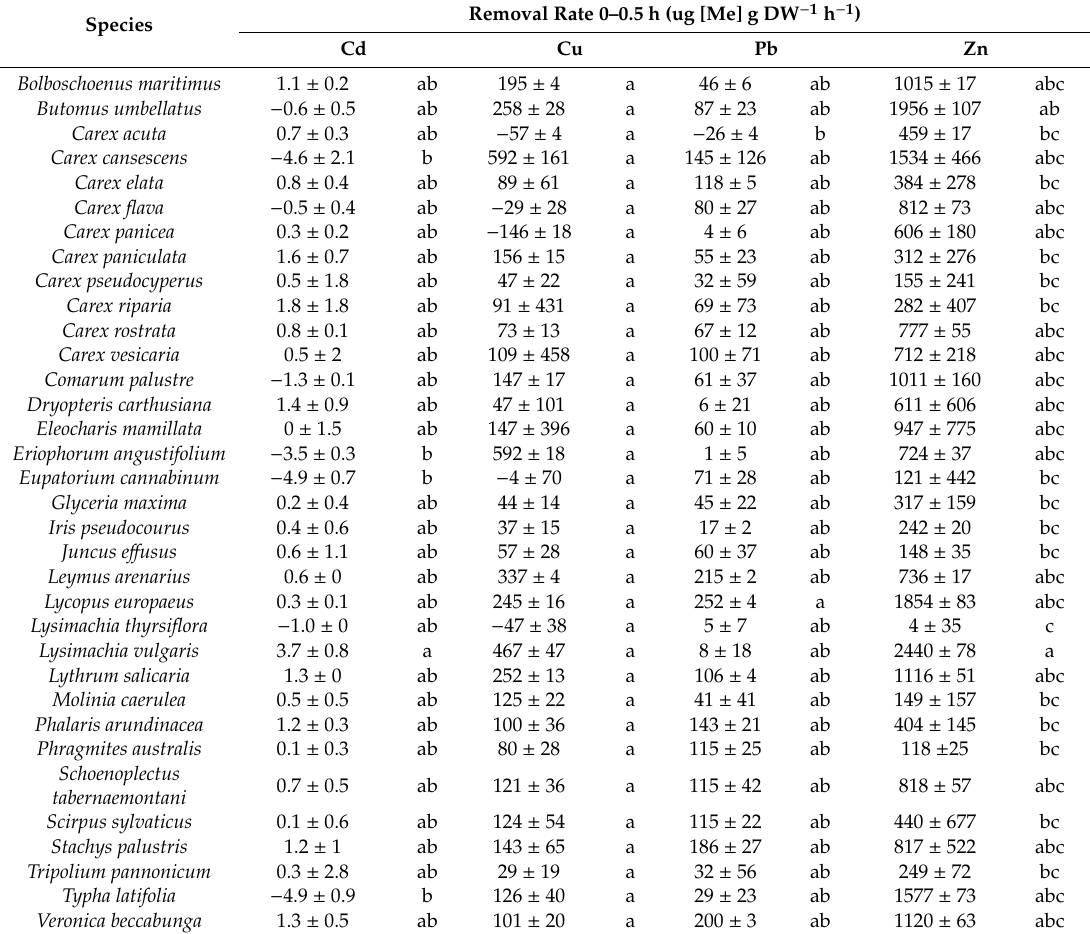
Table 2. Removal rates during the first 0.5 h of the experiment. Di ff erent letters within each metal denote di ff erences among species, where p < 0.05. n = 3, ±